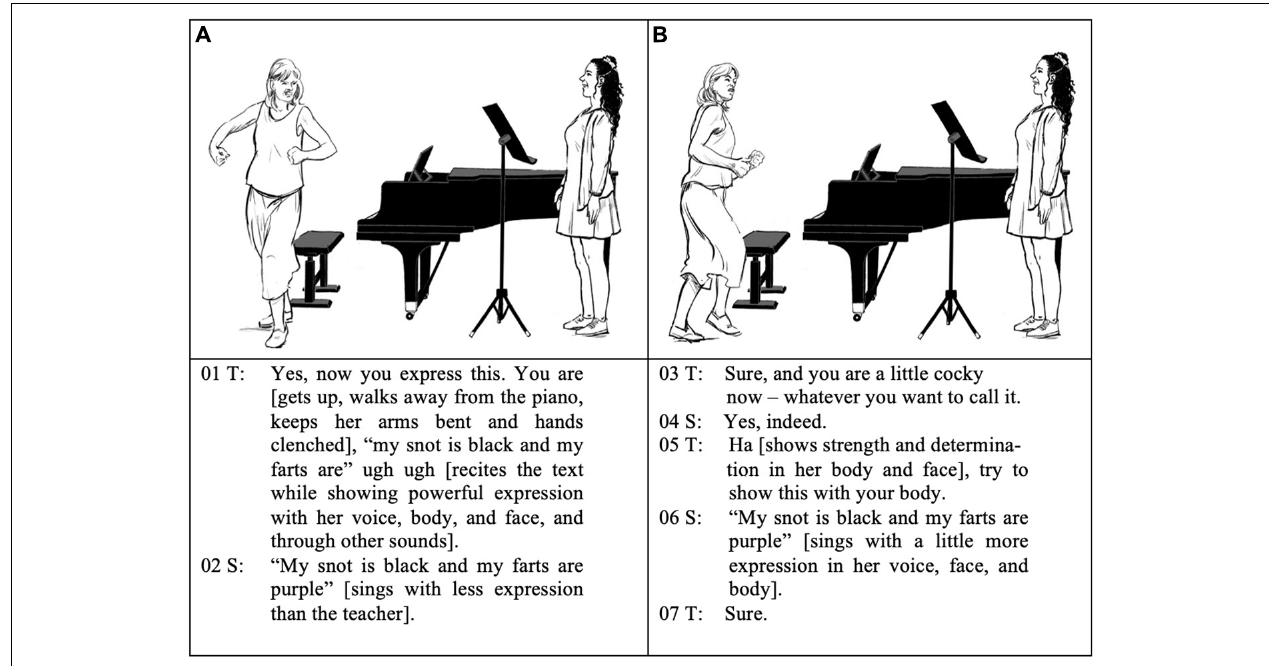
FIGURE 8 | Teacher dramatizing the text with words and facial grimaces (A) and the whole body (B)